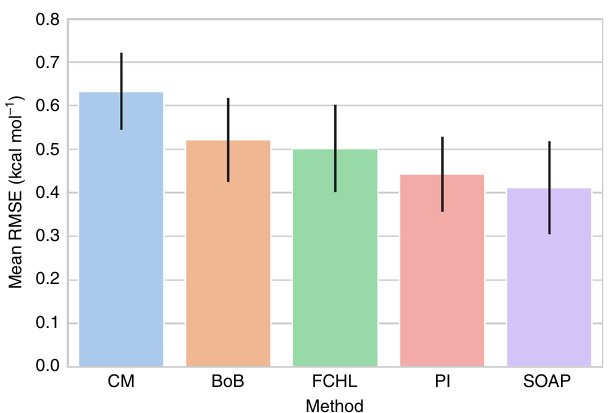
Fig. 3 Root-mean-square error (RMSE, in kcal mol − 1 ) of CO 2 interaction energies. The automated OpenBabel-generated structures were used for each molecular representation model. The error bars represent the standard deviation of the RMSE.